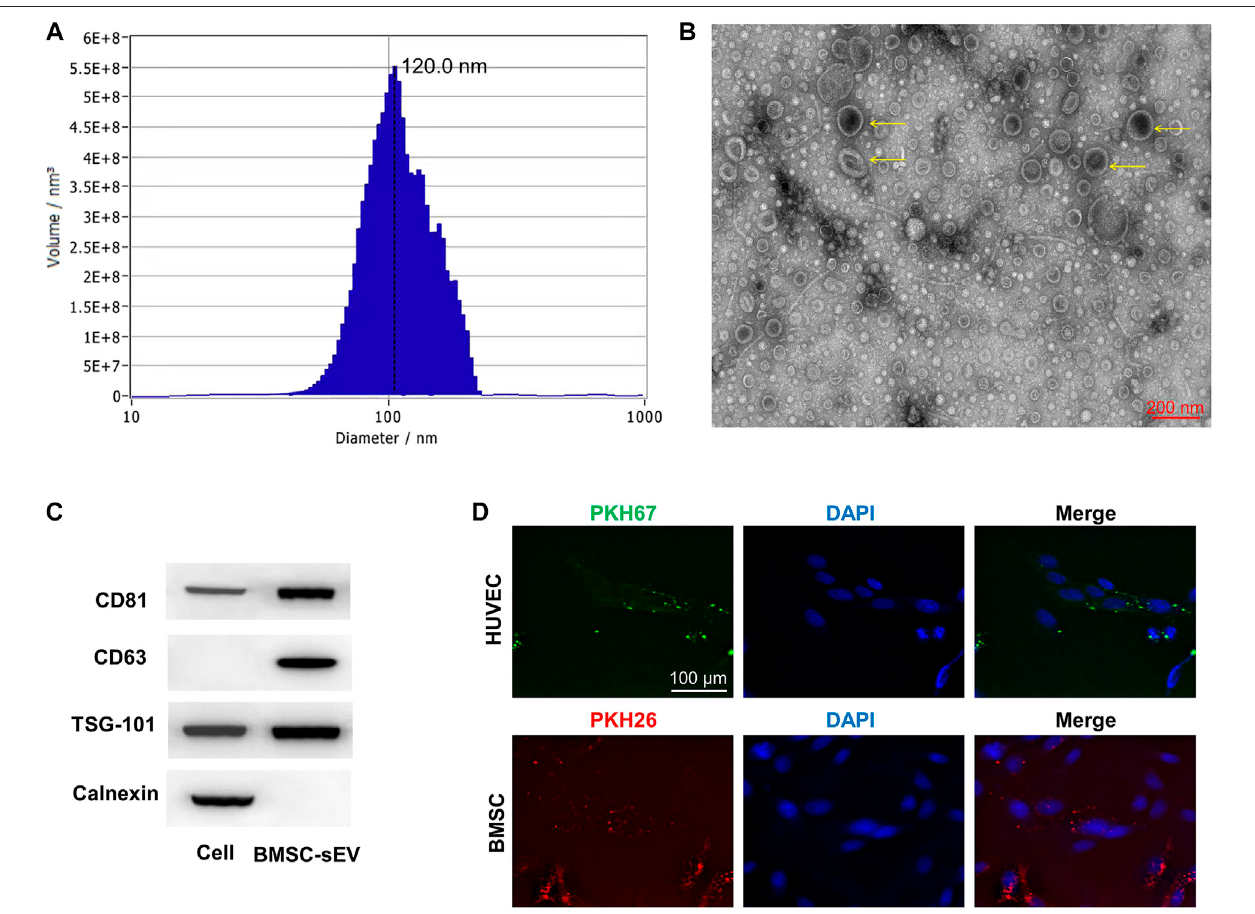
FIGURE 1 | Characterization and internalization of sEVs (A) Particle size distribution of sEVs detected by NTA and the mean diameter is 120.0 nm (B) Representative images of the morphology of sEVs by TEM. The yellow arrows indicate sEVs. Scale bar (cid:1) 200 nm (C) Western blotting analysis of the exosomal proteins CD63,CD81,TSG101andthenegativemarkerCalnexin (D) Uptakeofgreenfuorescentdye(PKH67)-labeledandredfuorescentdye(PKH26)-labeledsEVsbyHUVECs and BMSCs,